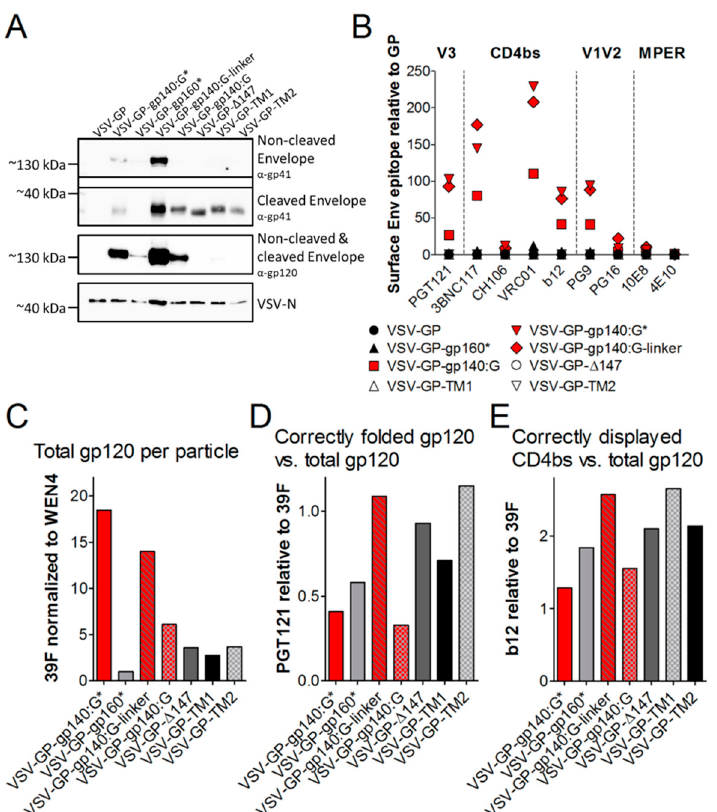
Figure 4. HIV Env is incorporated into VSV-GP particles and displays epitopes crucial for binding of bnAbs. The different VSV-GP particles (VSV-GP, VSV-GP-gp140:G*, VSV-GP-gp160*, VSV-GP- gp140:G-linker, VSV-GP-gp140:G, VSV-GP- Δ 147, VSV-GP-TM1 and VSV-GP-TM2) were produced on BHK-21 cells and concentrated via low-speed centrifugation using a sucrose cushion. ( A )